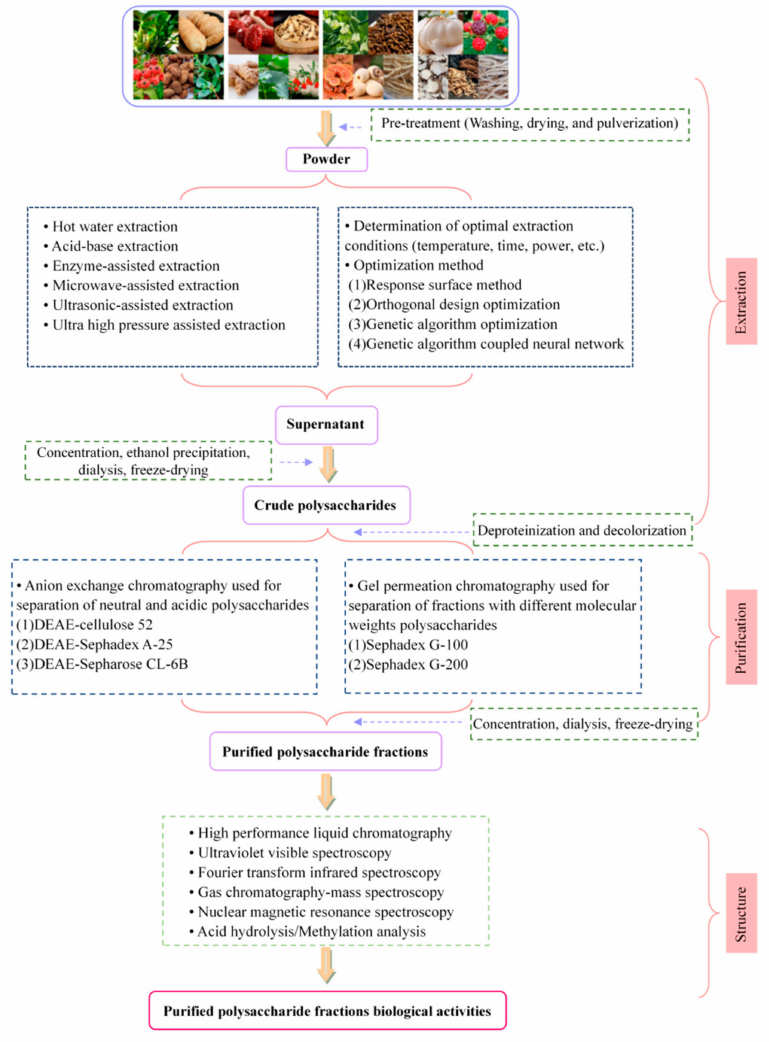
Figure 1. The extraction and purification process of